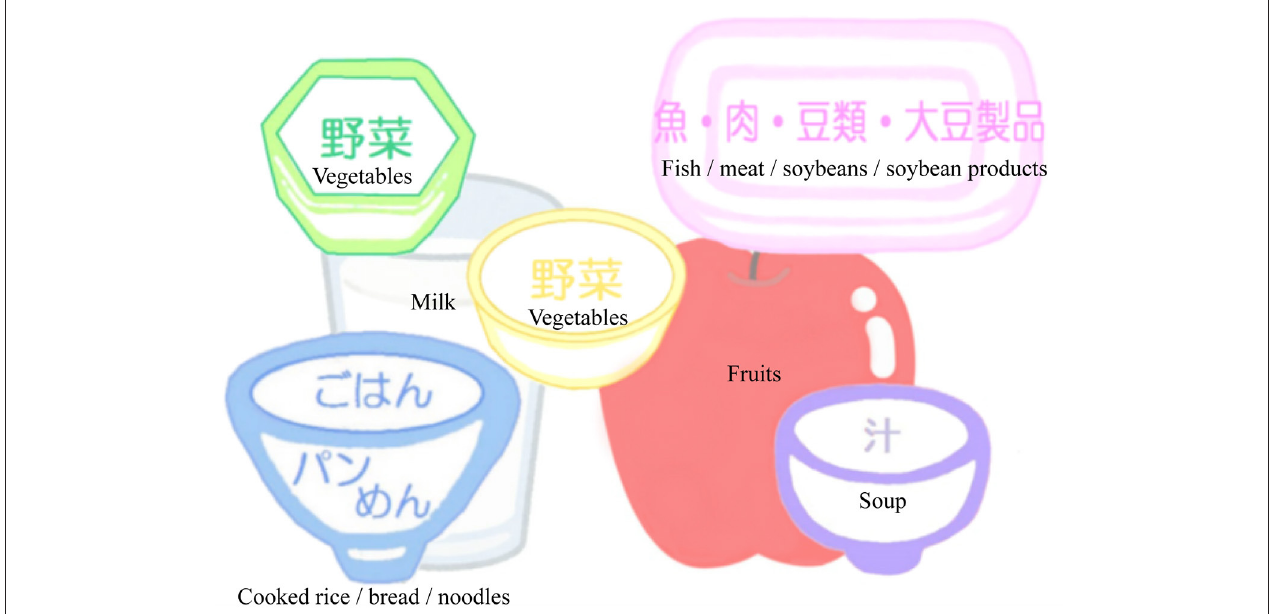
FIGURE 3 | Place mat illustrating dietary variety. Subjects are instructed to take well-balanced diet and increase dietary diversity arranging dietary staples (Cooked rice, bread, or noodles), main dishes (fish, meat, soybeans and soybean products), side dishes (green and yellow vegetables and seaweeds), soup, fruits, and milk and dairy products on a place